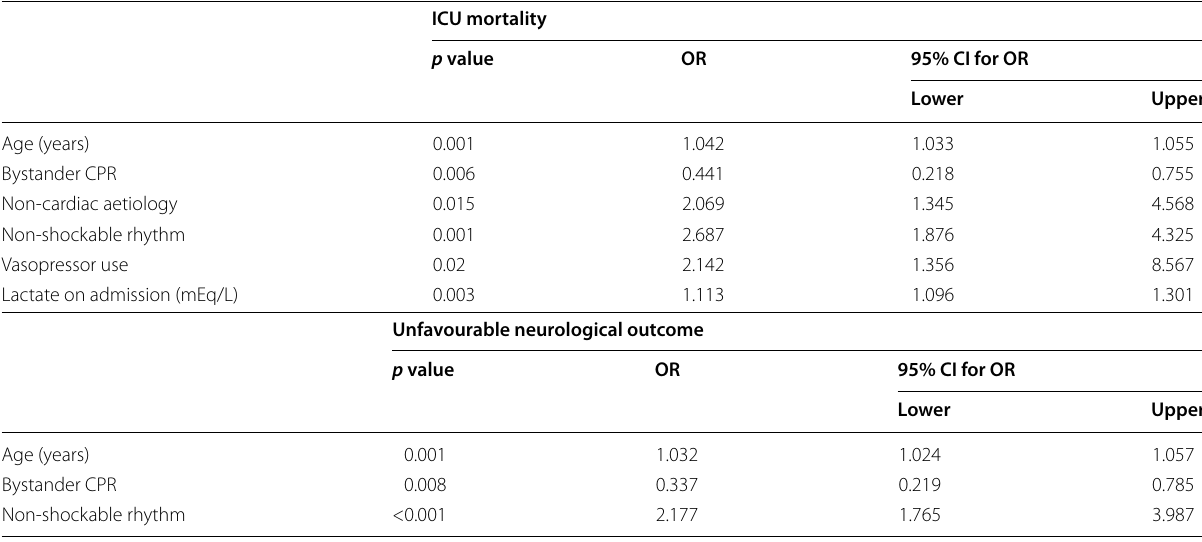
logical outcome at 3 months after cardiac